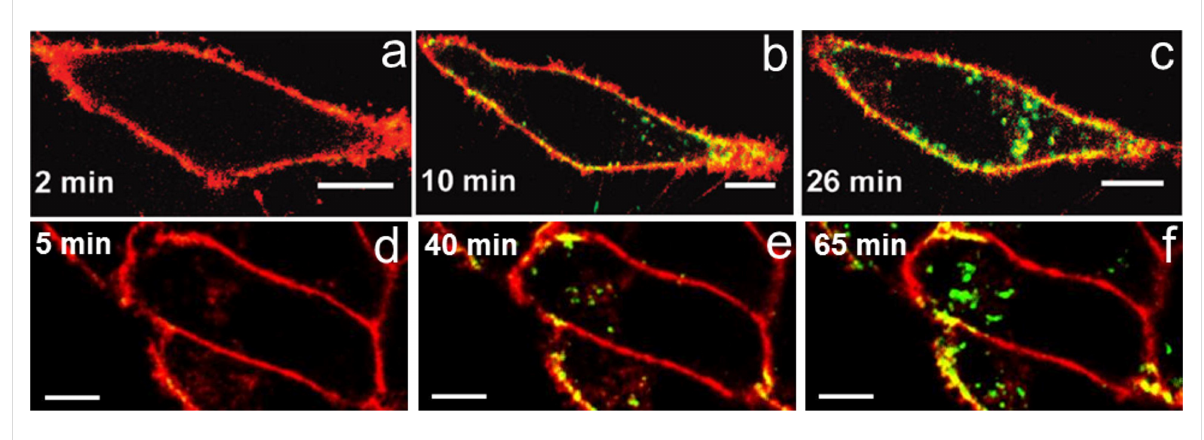
Figure 2: Typical two-color merged confocal fluorescence microscopy images of live HeLa cells exposed to NPs (green); times after the start of NP incubation is given in the panels. (a–c) DPA-QDs, 10 nM in PBS; (d–f) DHLA-AuNCs, 20 µg/mL in serum-free DMEM. Scale bar, 10 µm. Cell membranes (stained with CellMask DeepRed) are depicted in red. Images in panels a–c were reproduced with permission from [31]. Copyright 2010 American Chemical Society. Images in panels d–f were reproduced with permission from [34]. Copyright 2013 Royal Society of Chemistry.